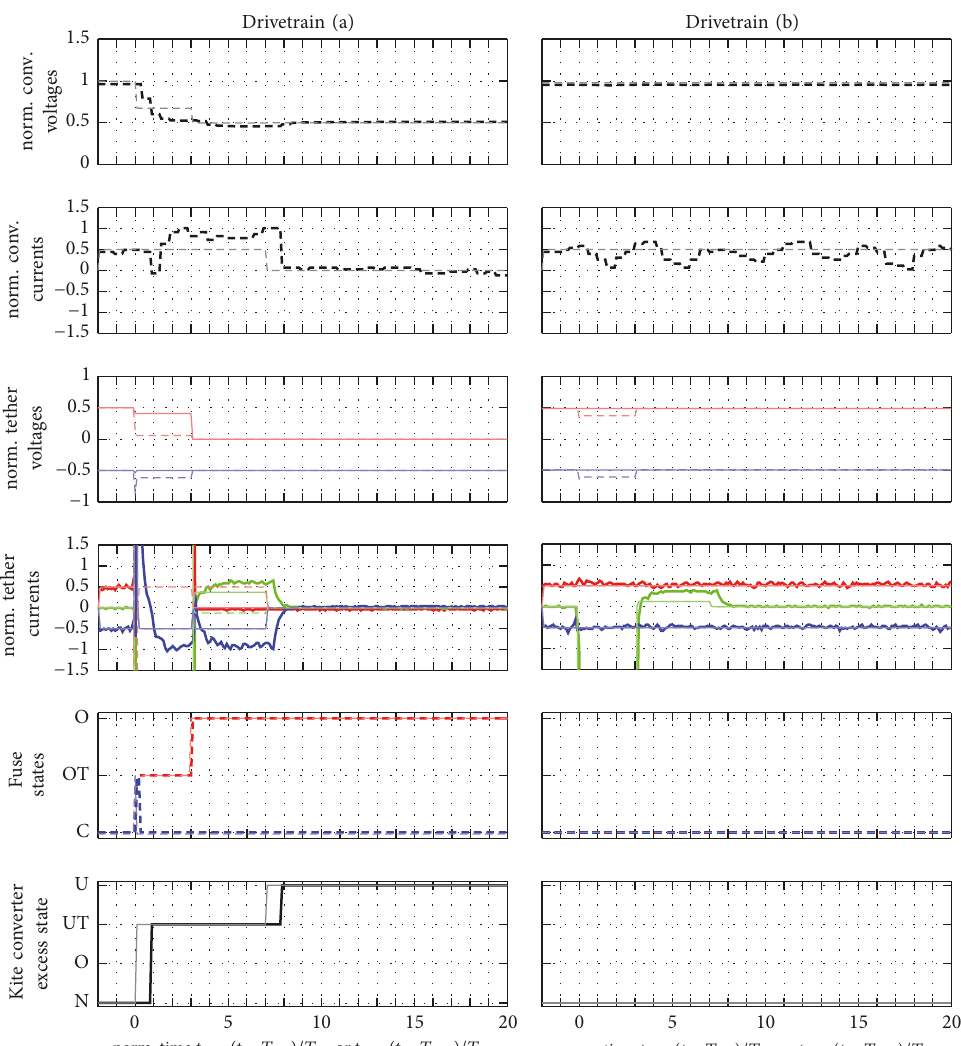
Figure 25: Measured (bold) and simulated (thin and light) voltages, currents, and states for short circuit fault S2 in motor mode, with the same colors as in Figure 18. For the measurements, the time is normalized 𝑡 instead of to the fault time 𝑇 as for the simulation fault